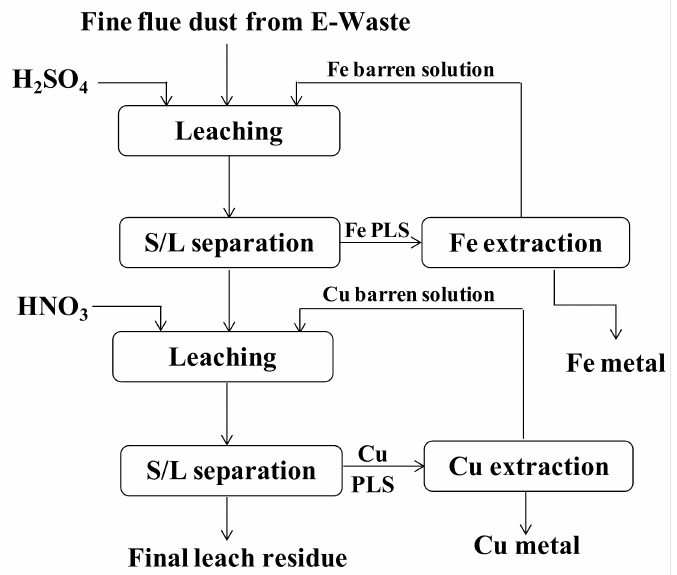
Figure 4. Metal leaching from e-waste flue dust (redrawn with modifications following